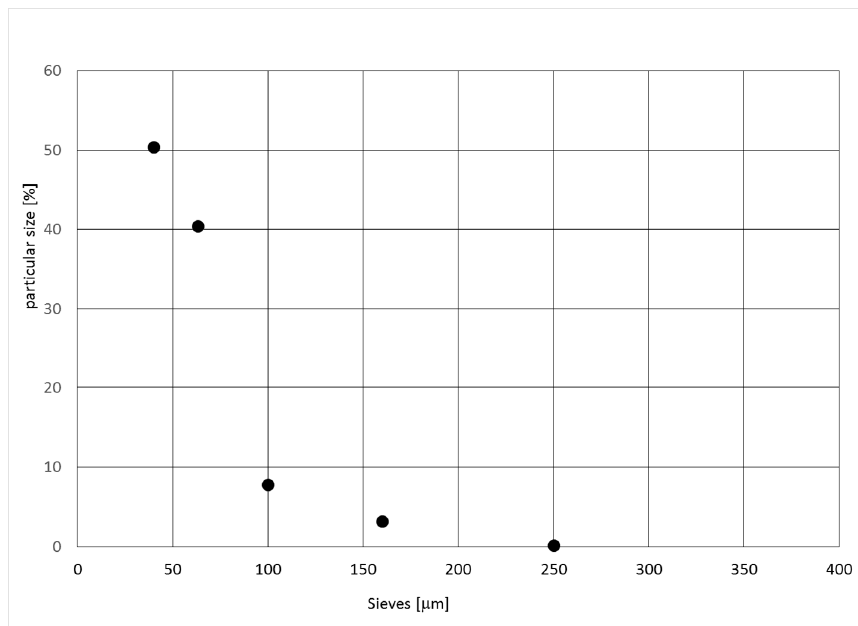
Figure 2. Particle size in % of the industrial dust.